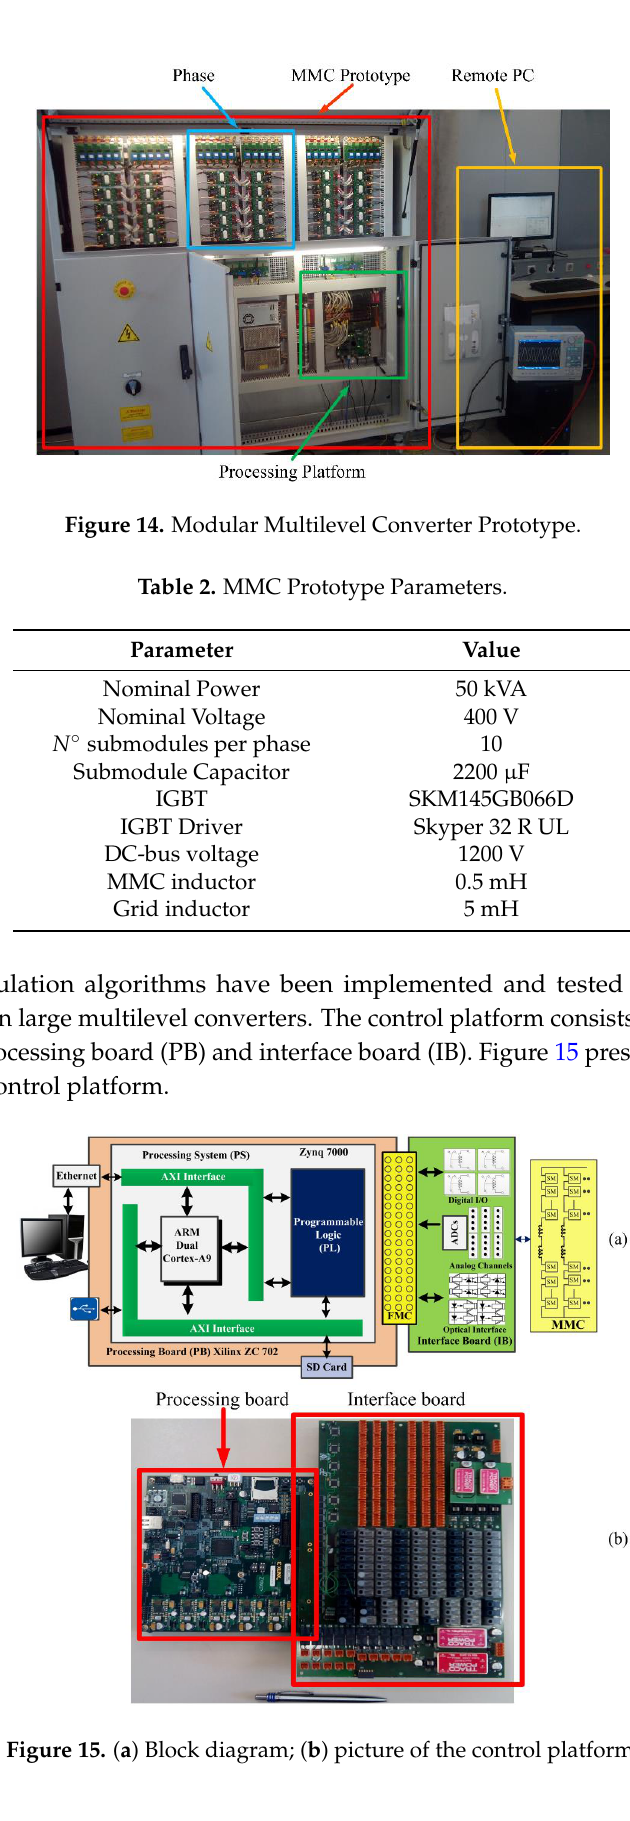
Figure 15. ( a ) Block diagram; ( b ) picture of the control platform.